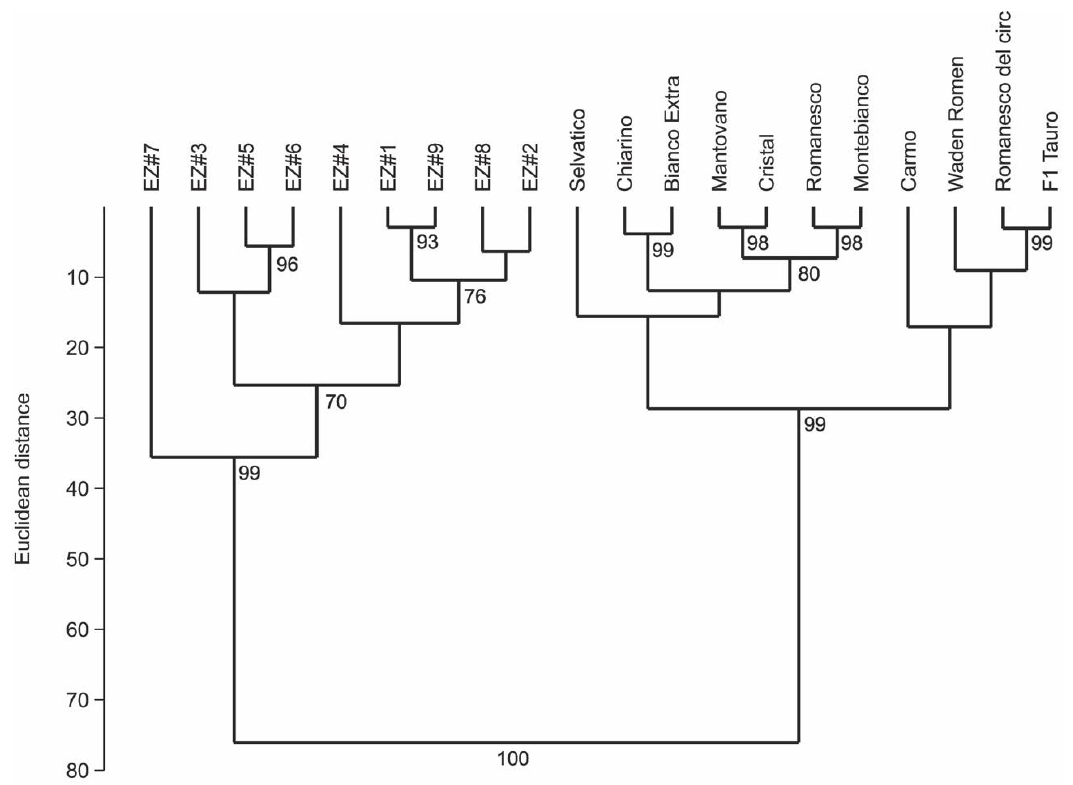
Figure 2. Ward’s clustering dendrogram of F. vulgare accessions.